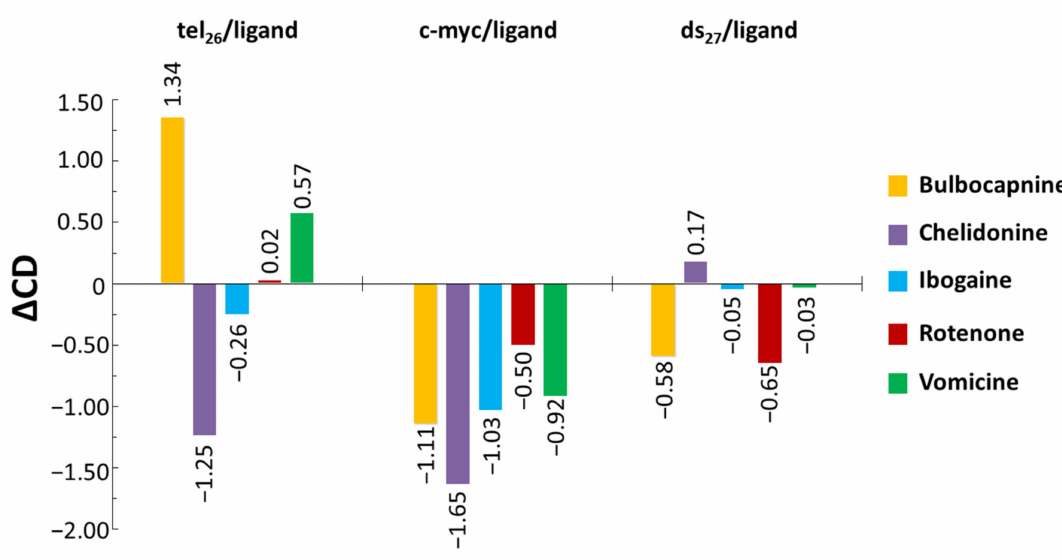
Figure 2. Bar graph representing ∆ CD values calculated as the differences between the CD intensity of DNA/ligand 1:10 ratio systems (after ligand contribution subtraction) and the CD intensity of DNA alone considering the CD values at 290, 262 and 251 nm for tel 26 , c-myc and ds 27 systems, respectively. The errors associated with ∆ CD values are within ±